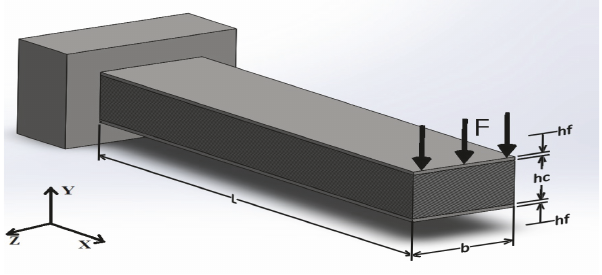
Figure 1: Geometry of sandwich